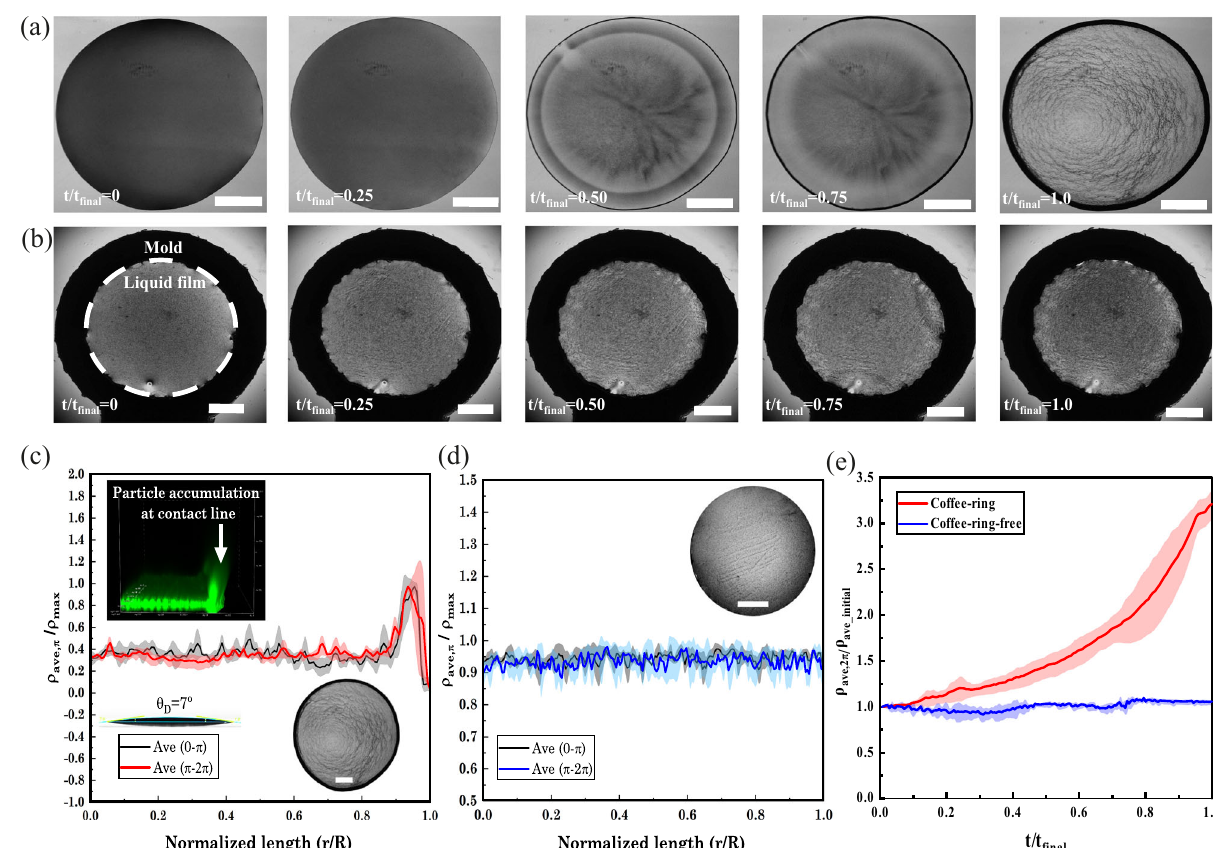
Fig. 2 Coffee-ring versus coffee-ring-free nanoparticle deposition. a , b Comparing the coffee-ring and coffee-ring-free particle depositions: experimental snapshots of the transportation of particles over time during evaporation. Scale bars in a and b are 500 and 1000 μ m, respectively; The dark ring in b is the shadow mold (PSA layer). c The average density of deposited carbon nanohorn (CNH) nanoparticles with a size of 100 nm and zeta potential of − 37.67 mV, dispersed in deionized (DI) water at a concentration of 0.5 mg/ml, on substrates with two different contact angles of 7° and 32°; scale bar: 500 μ m. d Comparison of the average density of nanoparticles in two halves of the circular deposited layer using the proposed protocol, which shows the uniform coating of the particles; scale bar: 1000 μ m. e Average distribution of the particles at the contact line over time is used to compare particle accumulation in the coffee-ring phenomenon and uniform particle deposition in the coffee-ring-free model. c – e Standard deviations are shown as shaded lines, with n = 3 for each case. Source data are provided as a Source Data fi